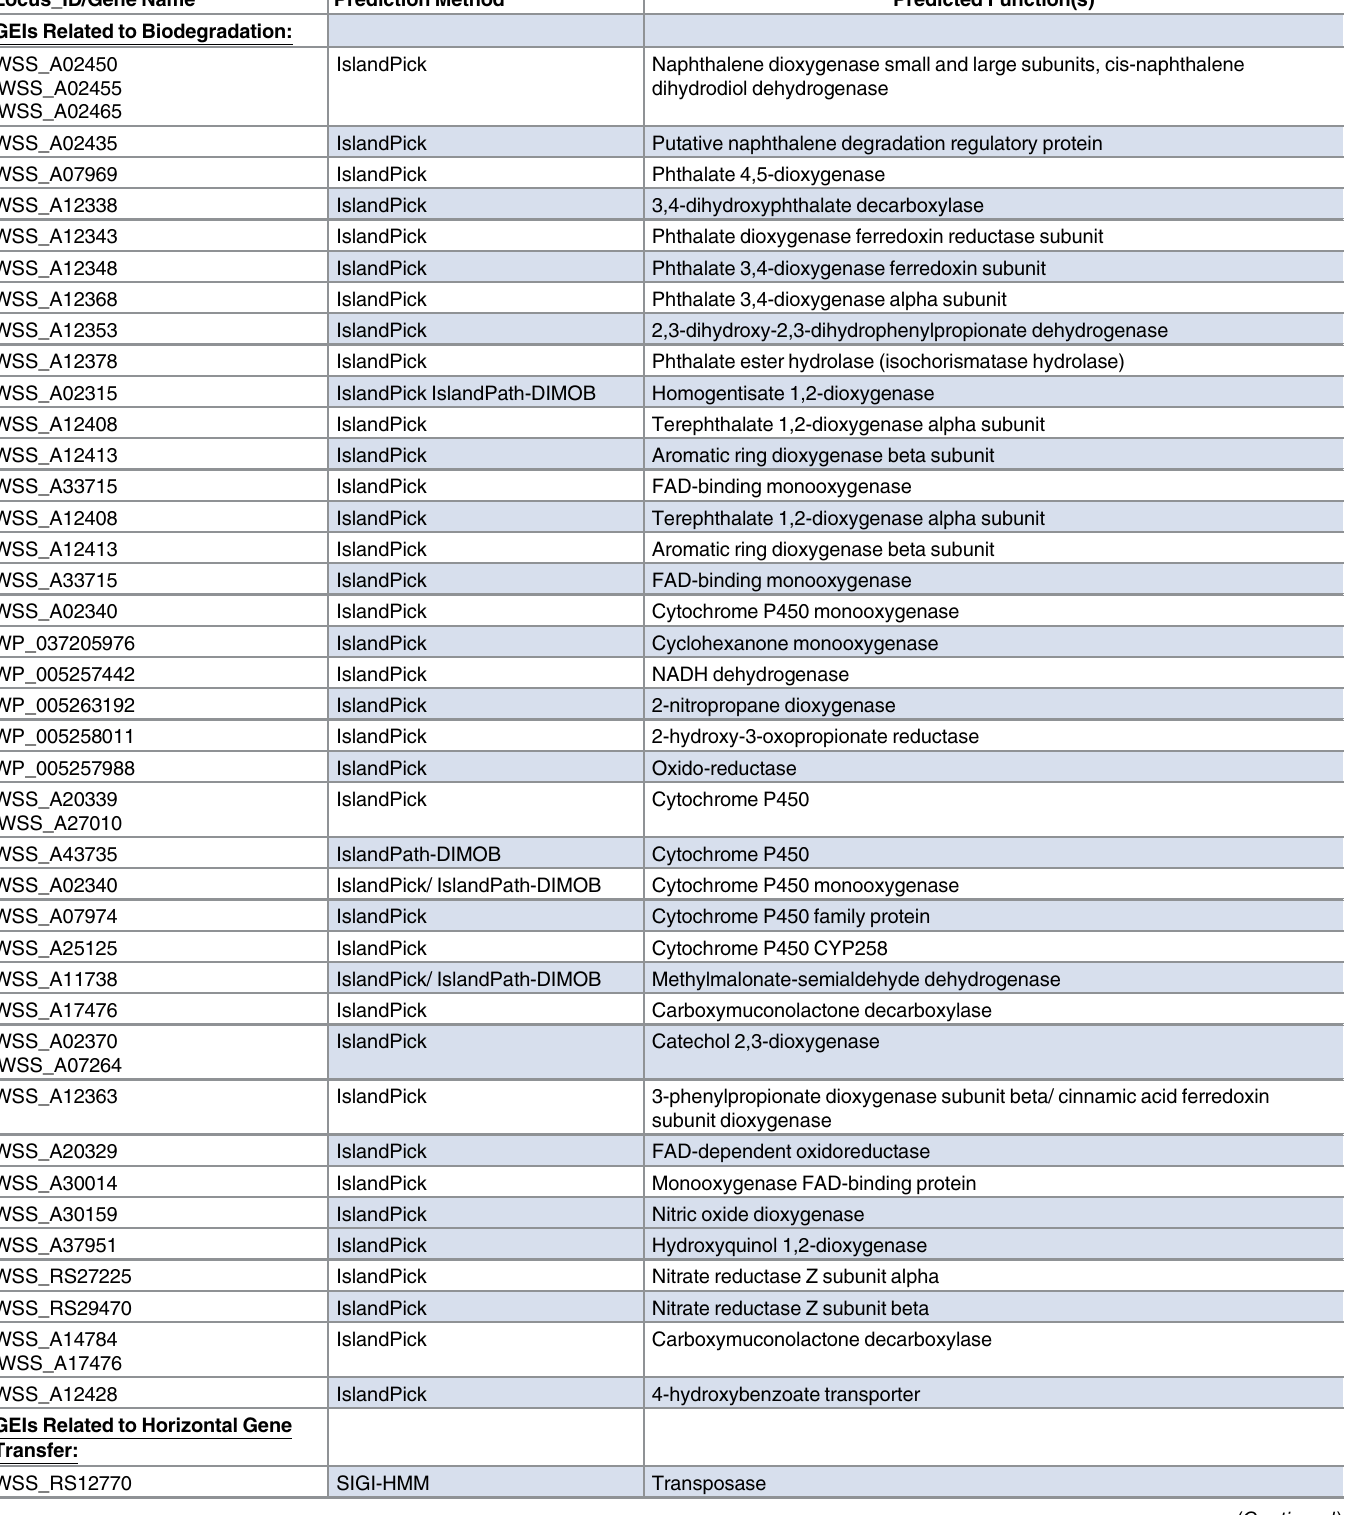
Table 2. Characteristics of some of the key genomic islands (GEIs) identified from the whole genome sequence of R . opacus strain